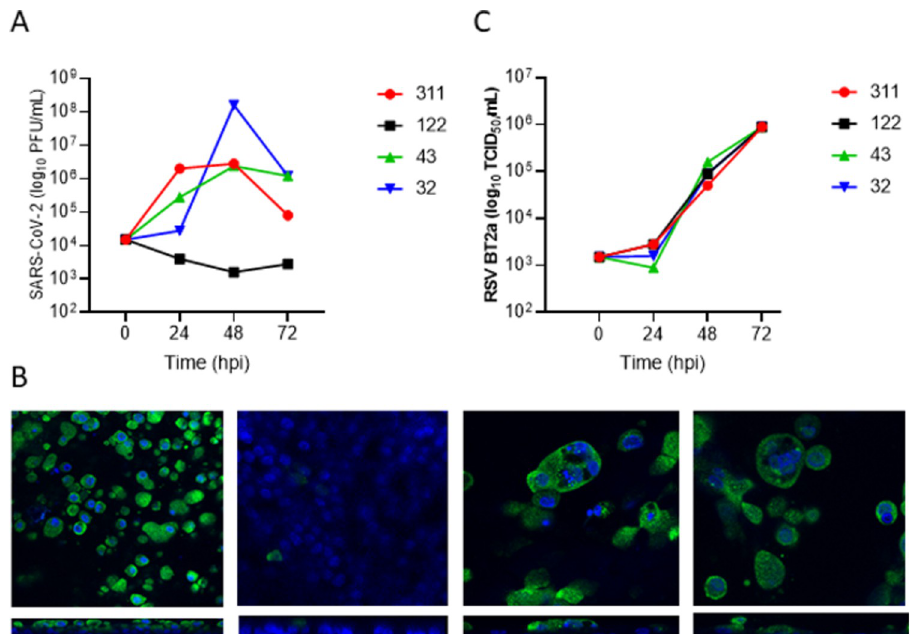
Fig 1. WD-PNECs from different donors are differentially susceptible to SARS-CoV-2, but not RSV. WD-PNECs from 4 adult donors were infected with a clinical isolate of SARS-CoV-2 (MOI = 0.1). Apical washes were harvested every 24 h and titrated by plaque assay on Vero cells (A). Cultures were fixed at 96 hpi and SARS-CoV-2 N protein (green) was detected by immunofluorescence. Nuclei counterstained with DAPI (blue). Images and orthogonal sections were obtained on a Leica SP5 confocal microscope at x63 magnification (B). In parallel, cultures from the same donors were infected with RSV (MOI = 0.1). Apical washes were harvested every 24 h and titrated on HEp-2 cells